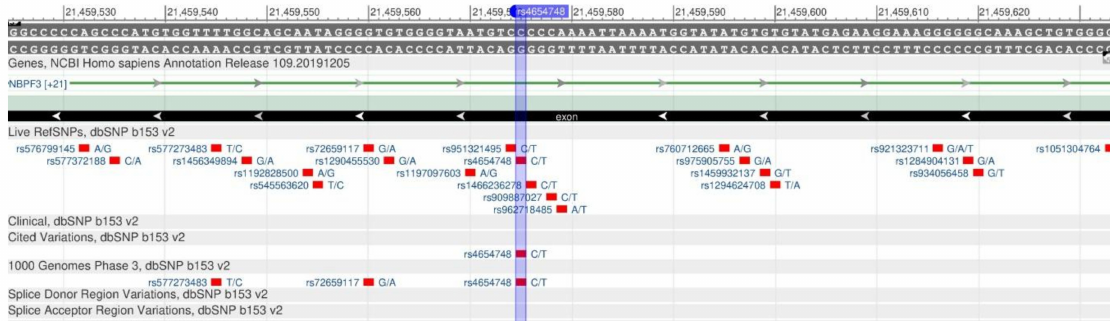
Figure 19. The NBPF3 gene region (located on the short (p) arm of chromosome 1) containing the oligonucleotide polymorphism rs4654748.